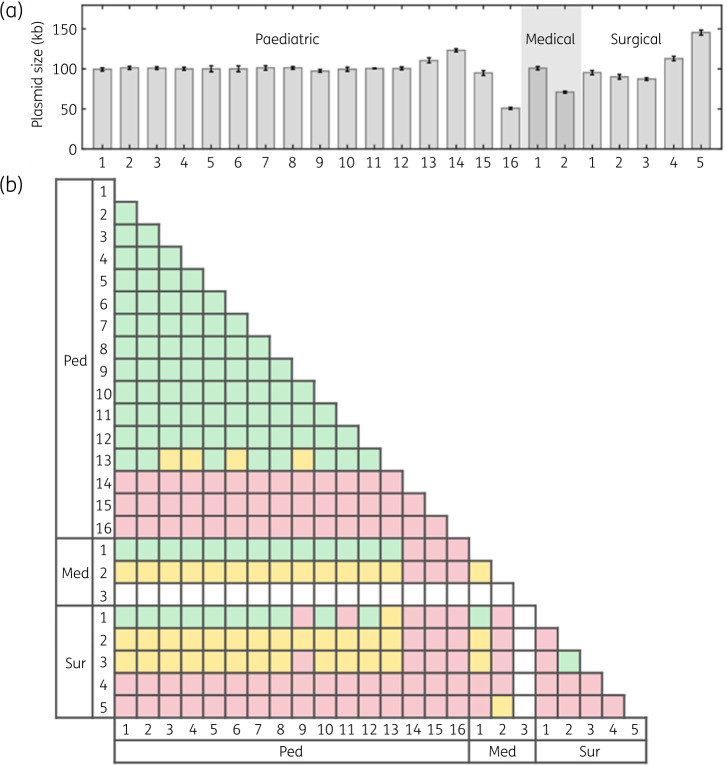
(a) Sizes of plasmids from the paediatric, medical and surgical wards. Plasmid sizes are estimated by comparing with spiked λ-DNA of known length. For each plasmid, at least six barcodes are collected and averaged for size estimation, and error bars represent one standard deviation. (b) Similarity matrix of plasmids. Plasmids are compared pairwise. If the barcodes are similar when stretched to the same size (Pcomp < 0.01), they are considered complete matches and are labelled green. Barcode comparisons that do not match completely, but match when considering the size difference (Ppart < 0.01), are considered partial matches and are labelled yellow. Red boxes represent P > 0.01 for both comparisons.